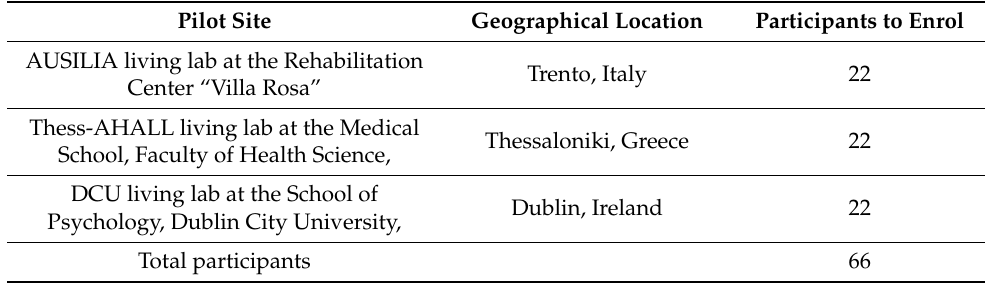
Table A1. Target end-user involvement per group and per pilot